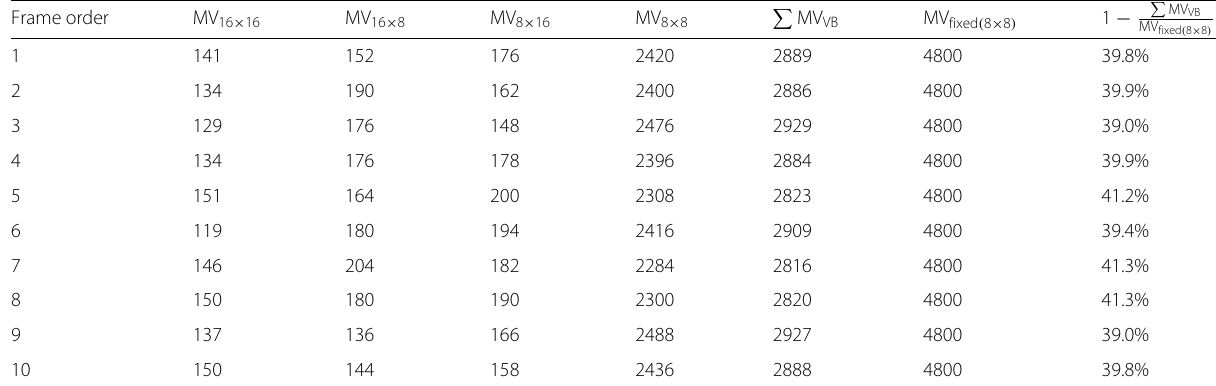
Table 7 Comparison of a number of MVs between variable- and fixed-size blocks (16 × 16, 16 × 8, 8 × 16, and 8 × 8) Frame